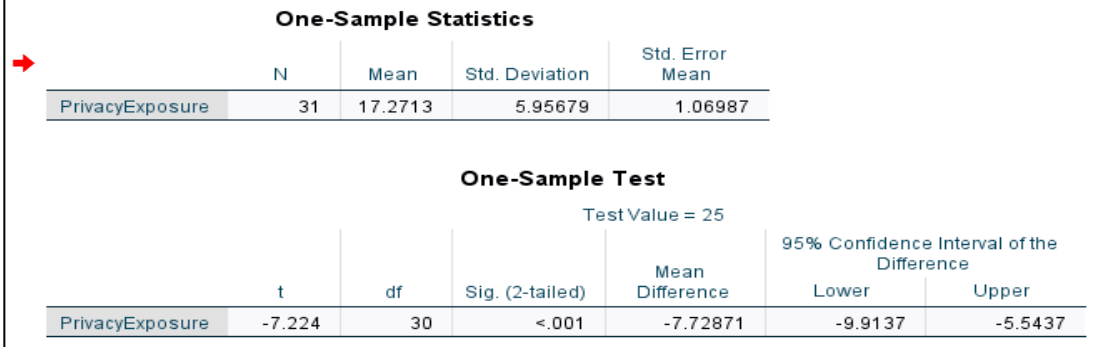
Figure 3. One-Sample T -Test output.